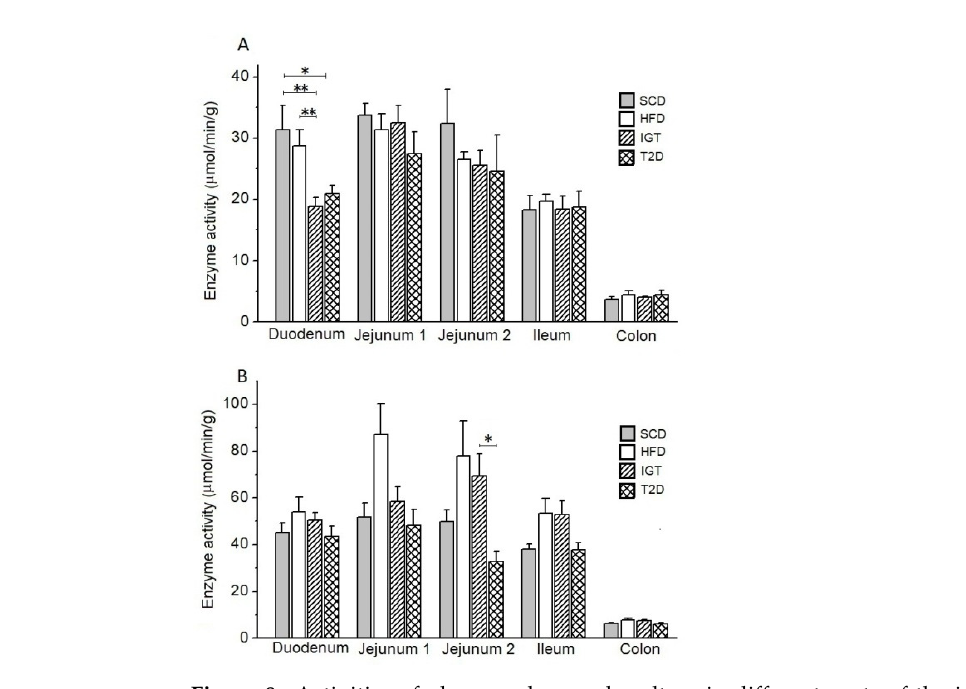
Figure 8. Activities of glucoamylase and maltase in different parts of the intestine in rats of 23 weeks old with type 2 diabetes (T2D), with impaired glucose tolerance (IGT) and in control groups: high-fat diet (HFD) and standard chow diet (SCD). ( A ) Glucoamylase activity; ( B ) maltase activity. ( A , B ) Jejunum 1 and 2 are proximal and distal halves of the jejunum, respectively. The T2D group ( n = 4), the IGT group ( n = 6), the HFD group ( n = 6) and the SCD group ( n = 6). Results are expressed as means ± the standard error of the mean (SEM). Student t-test: * p < 0.05 and ** p <